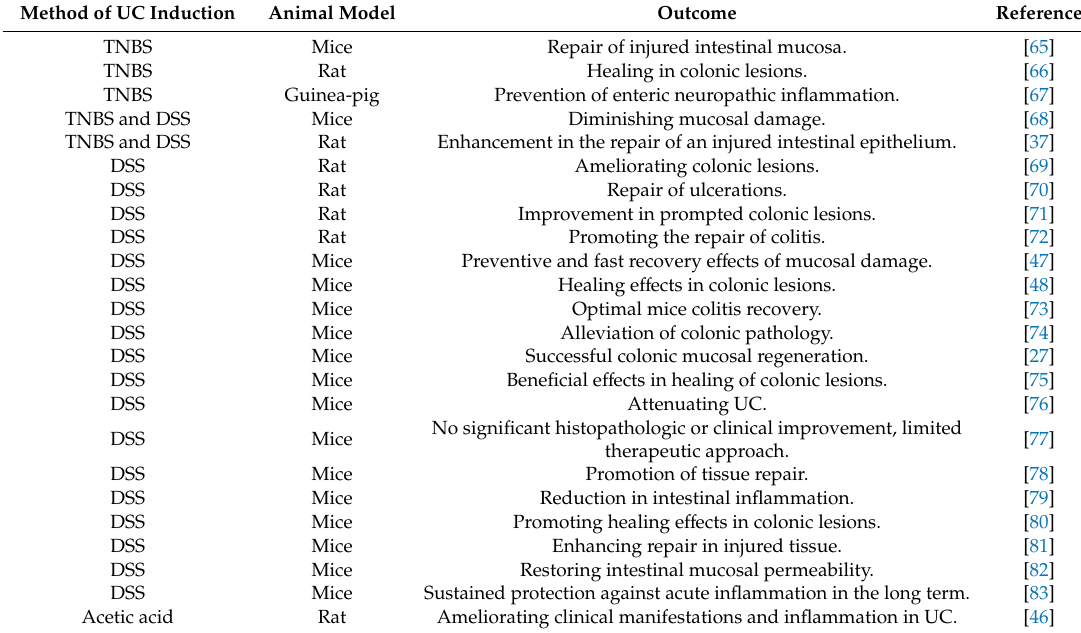
Table 4. In vivo studies in the treatment of UC using